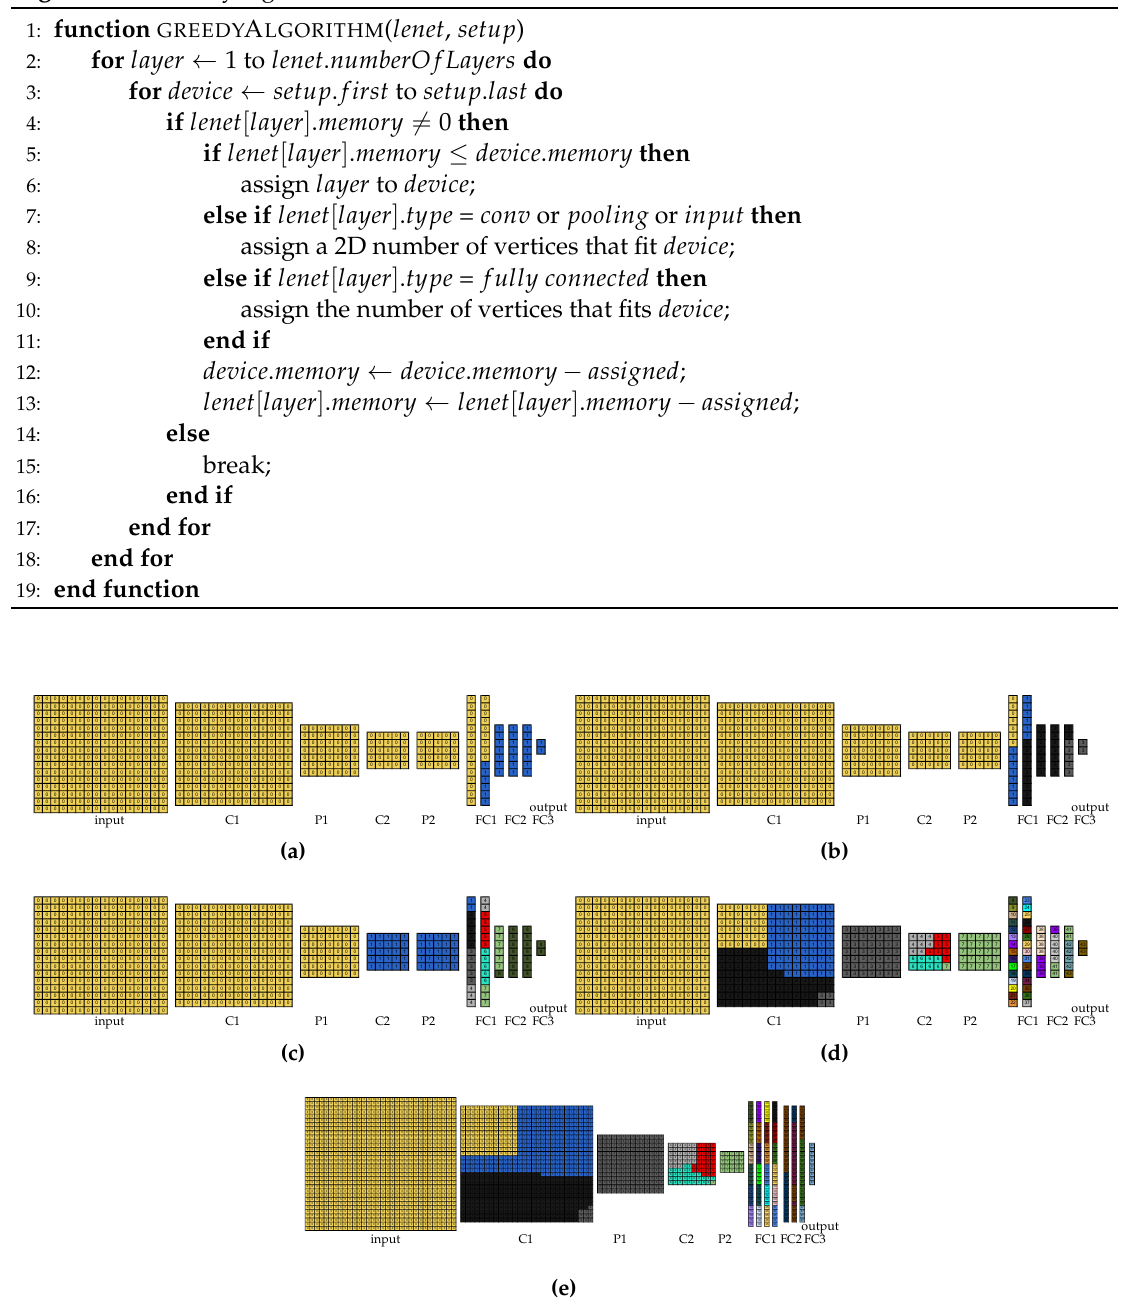
Figure 5. Partitionings using the greedy algorithm: ( a ) LeNet 2:1 for the two-device experiments; ( b ) LeNet 2:1 for the four-device experiments; ( c ) LeNet 2:1 for the 11-device experiments (used nine devices); ( d ) LeNet 2:1 for the 56- and 63-device experiments (used 44 devices); and ( e ) LeNet 1:1 for the 56- and 63-device experiments (used 38